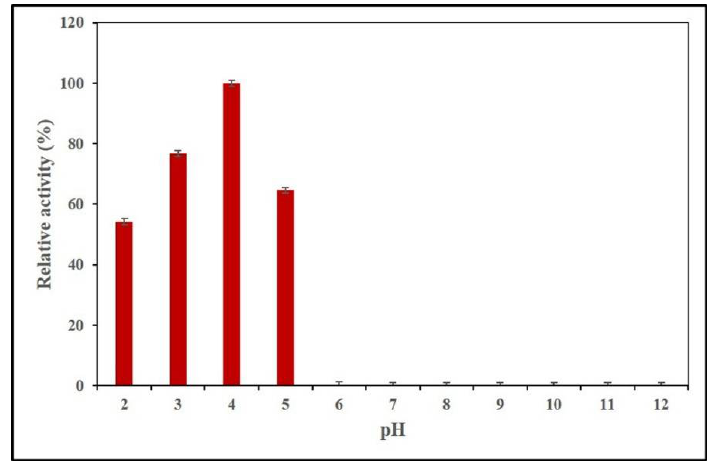
Figure 2. E ff ects of pH on AnEPG activity. Figure 2. Effects of pH on AnEPG activity. Figure 2. Effects of pH on AnEPG activity.